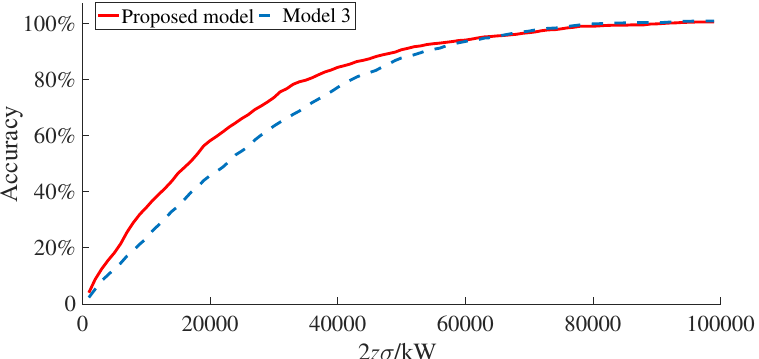
Figure 13. Accuracy under equal uncertainty (A/U) comparison between Model 3 and the proposed model.